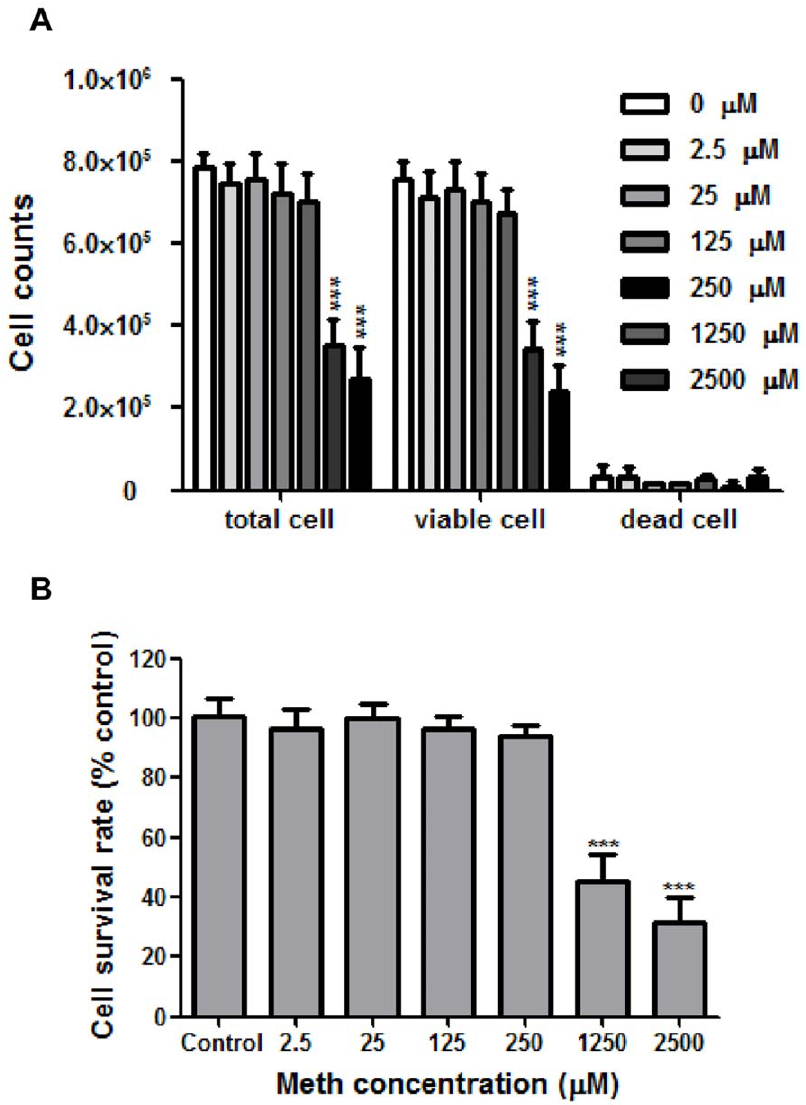
Figure 1. The cytotoxic effect of meth on human lung epithelial A549 cells. A549 cells were treated with meth at indicated concentrations at 37 u C for 72 h. (A) The trypan blue dye exclusion assay was performed to count the total, viable, and dead cells. (B) The cell survival rate was calculated, and data were expressed as percentages of viable counts in meth-treated groups relative to that in the meth-untreated group (control). The results are means 6 SD of five replicates from a representative result of three independent experiments. Significant differences were indicated (***: p , 0.0001 versus control).